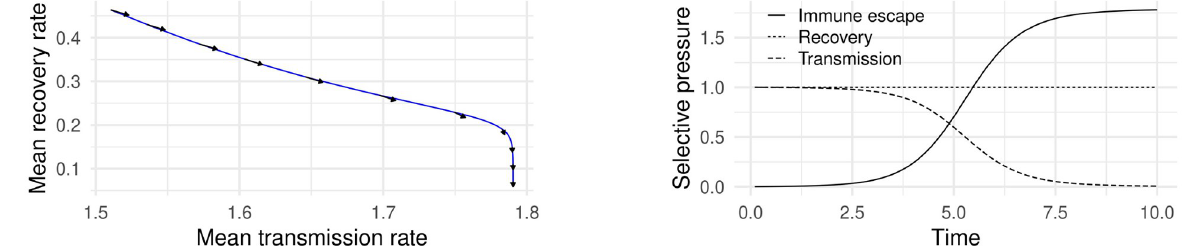
Fig 2. Mean phenotype and selective pressure over the course of a simulated outbreak using (3)–(5). ( a ) � b and � g over the course of a simulated outbreak. Arrows indicate the direction of h S = S